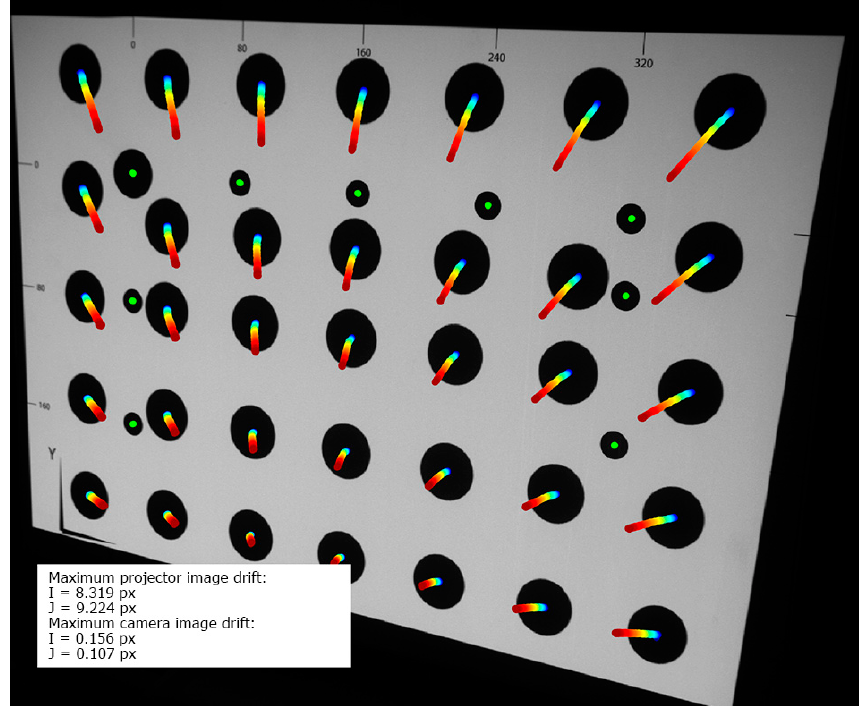
Figure 7. Thermal image drift of the LightCrafter 4500 during the warming-up process. The background frame is the first registered frame (immediately after turning on the projector). There are two types of markers: thirty-five big black markers, displayed by the projector, and nine smaller black markers (marked with bright green color), printed on the validation artefact. The marker trajectories are multiplied 20 times. The colors show the temperature of the projector (blue dot: temperature around 24 ℃ , red dot: temperature around 43 ℃ ).